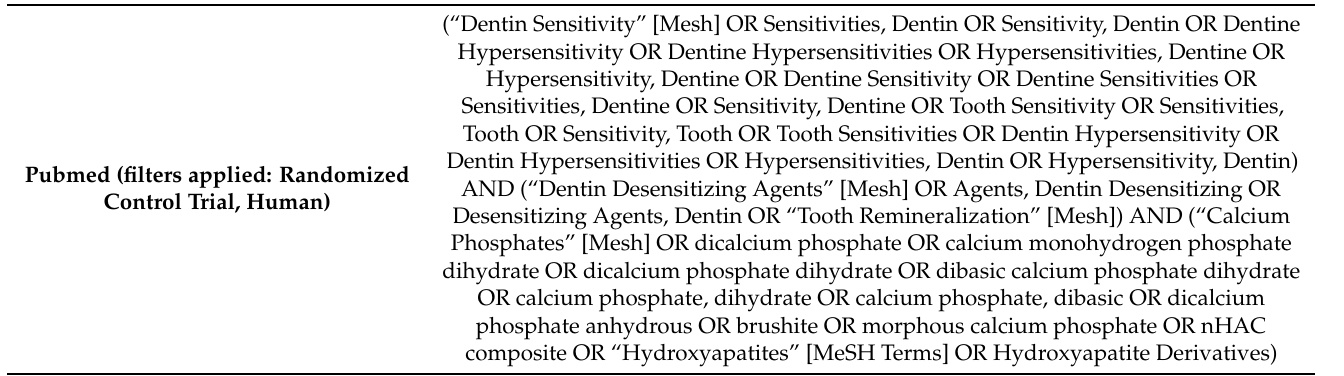
Table 1. Database and search